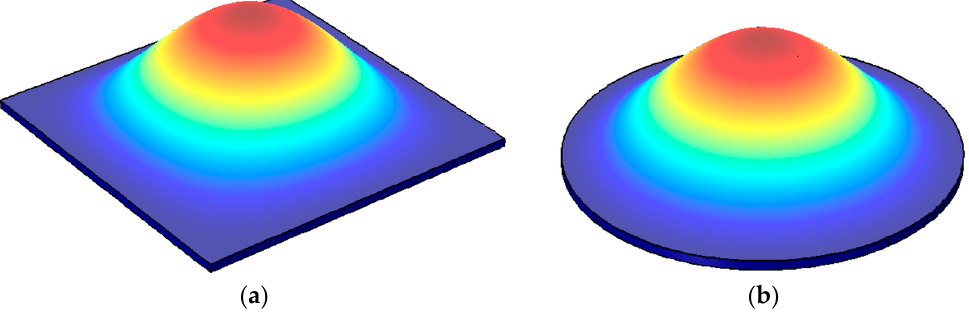
Figure 5. Common flexural mode membrane resonators: ( a ) square membrane; ( b ) circular membrane.